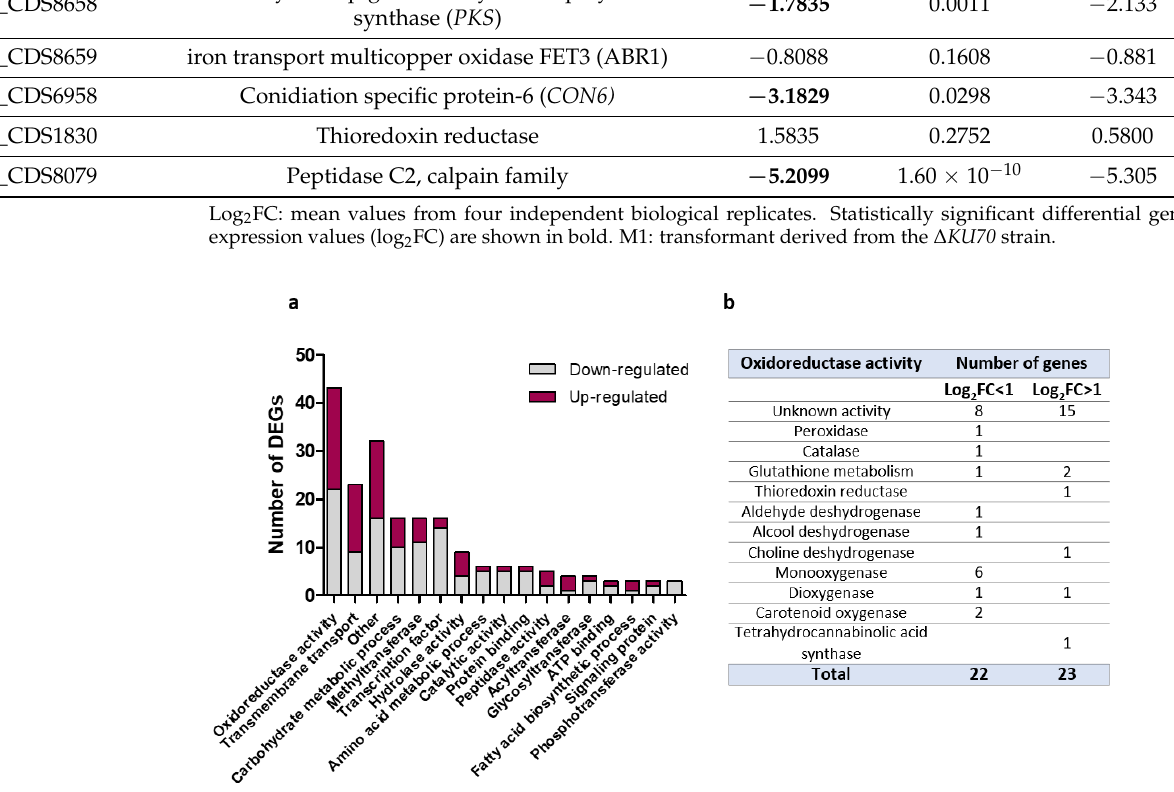
80 DEGs with unknown function are not included. ( b ) Detailed functions of DEGs involved in an